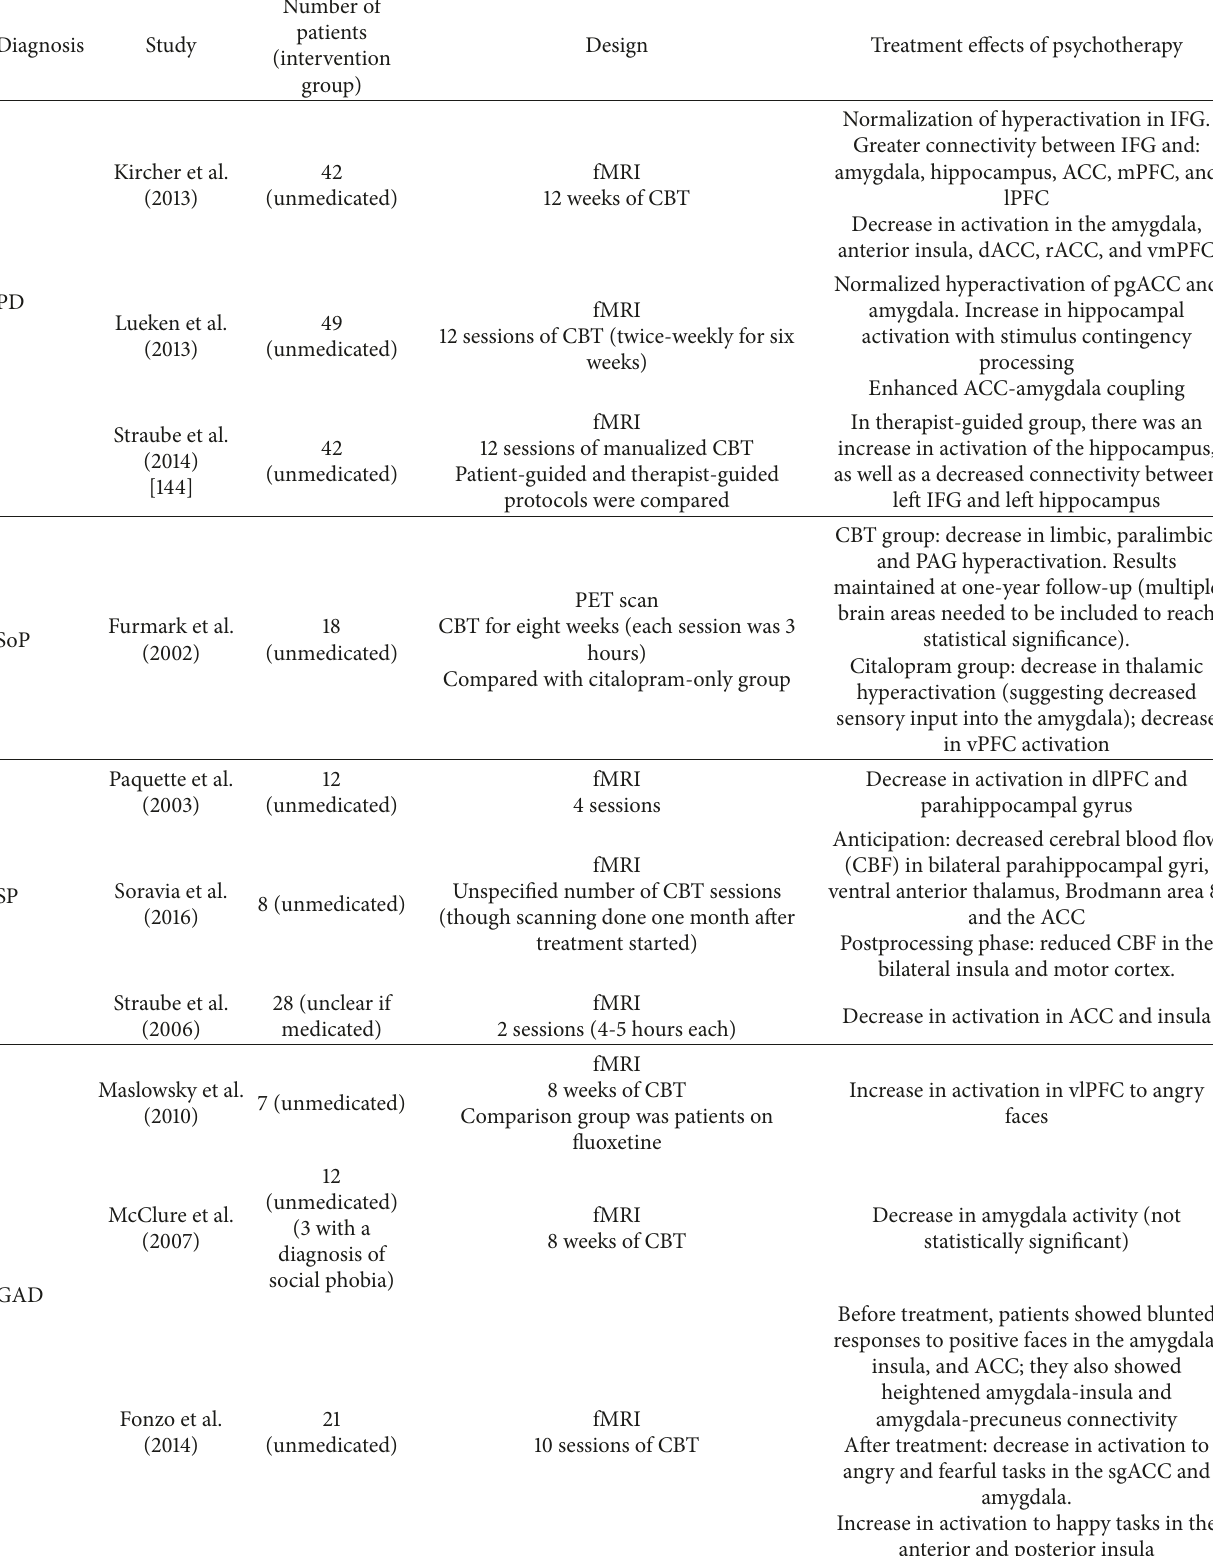
(a) Description of psychotherapy and neuroimaging studies: CBT for anxiety disorders ∗